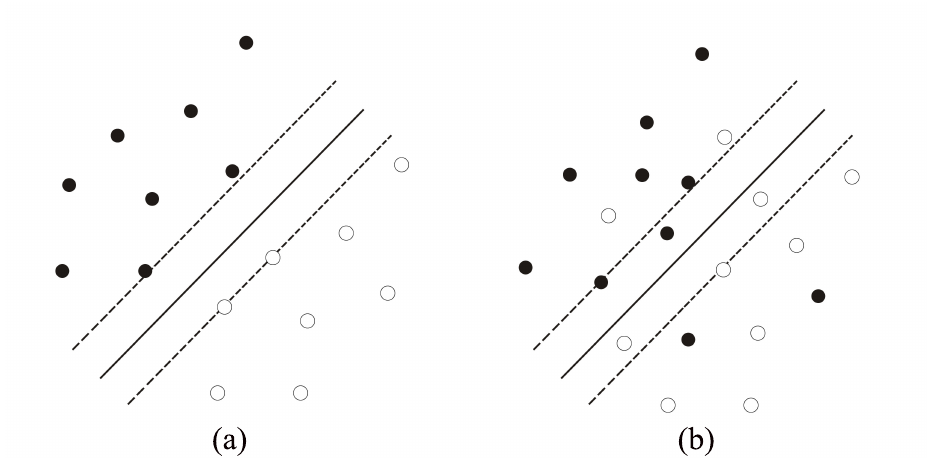
Figure 6. Representation of a linear SVM using ( a ) rigid margins and ( b ) soft margins. Source: Adapted from [49] and prepared by the